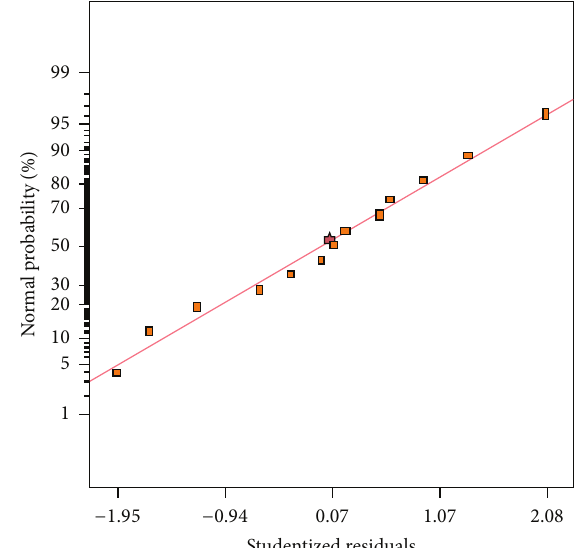
Figure 3: Normal probability of studentized residuals for biomass